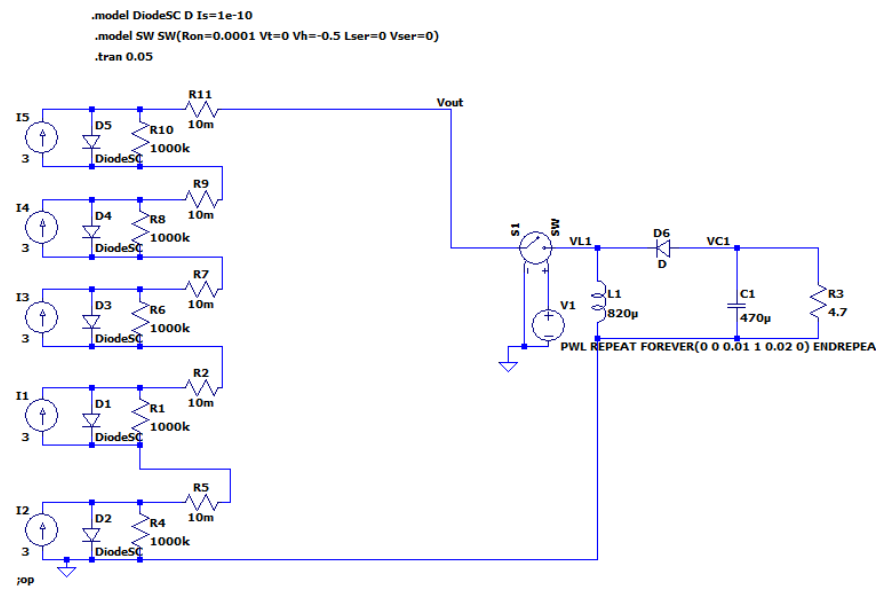
Figure 20. Circuit for simulating tracers based on DC–DC converters.